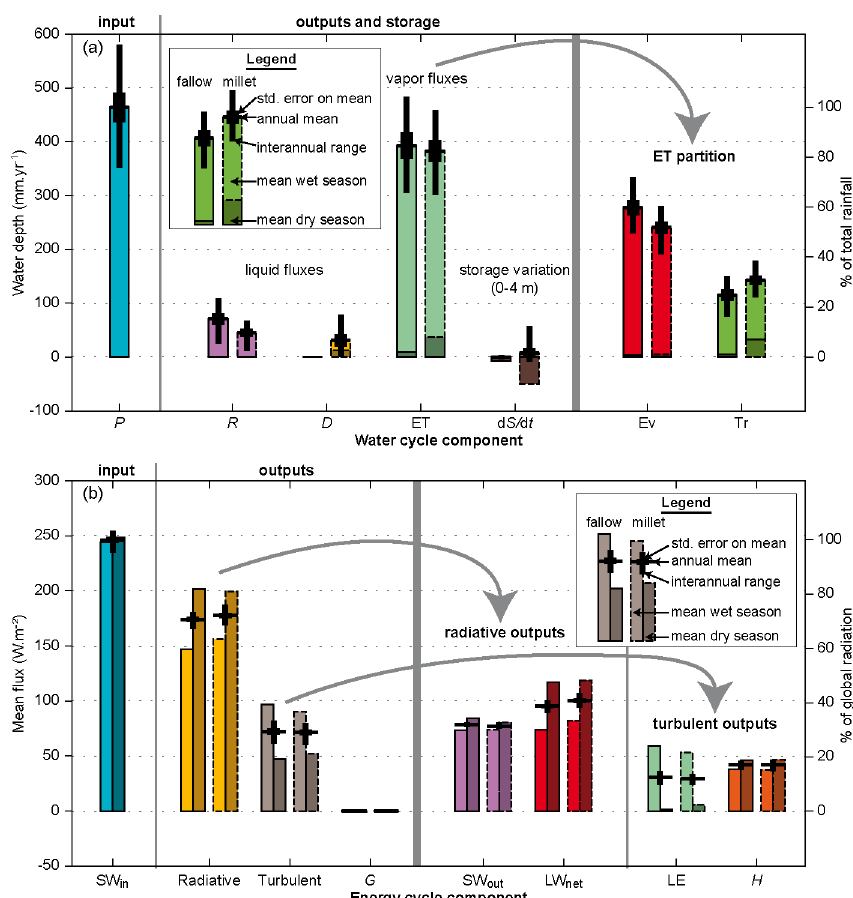
Figure 5. Estimated (a) water and (b) energy budgets at annual and semiannual scales: interannual ranges (black thin bars), annual means with standard estimation errors (black thick bars), and seasons means (light color for wet season, May–October; dark color for dry season, November–April), for the fallow (solid contours) and millet (dashed contours) plots. See Eq. (1) for abbreviations. Note that half-year water depths (color bars in a ) are stacked to yield annual values, whereas annual energy fluxes are obtained as the means of half-year mean intensities (b)